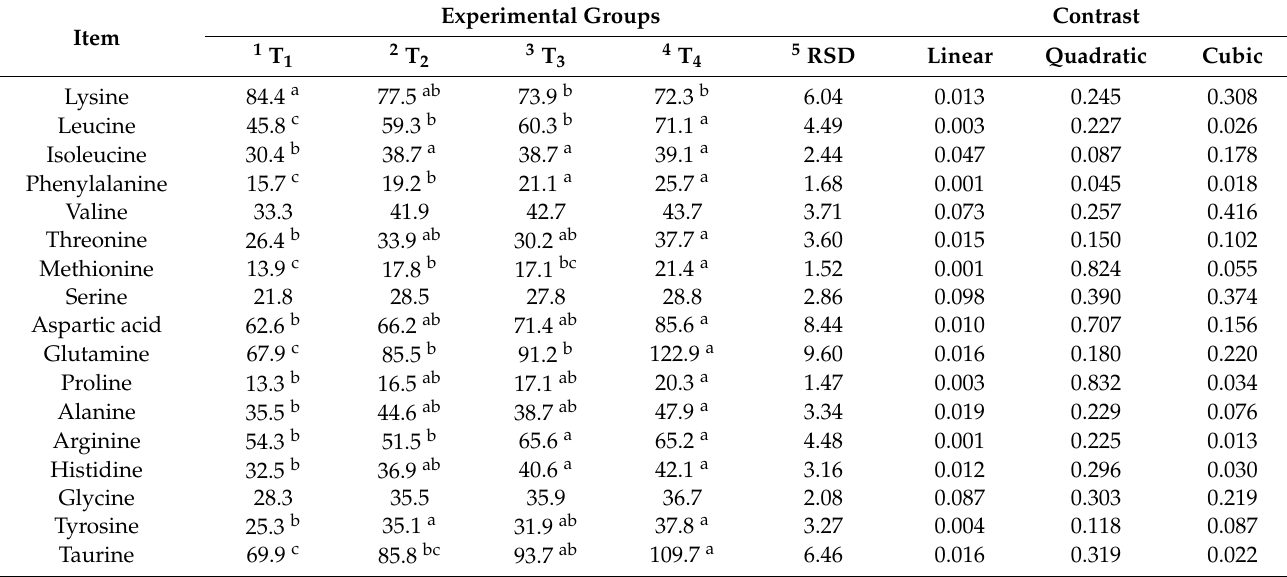
Table 2. Effect of dietary supplementation with GA on the amino acid profile (g 100 g − 1 ) of the breast muscles in laying hens. Item